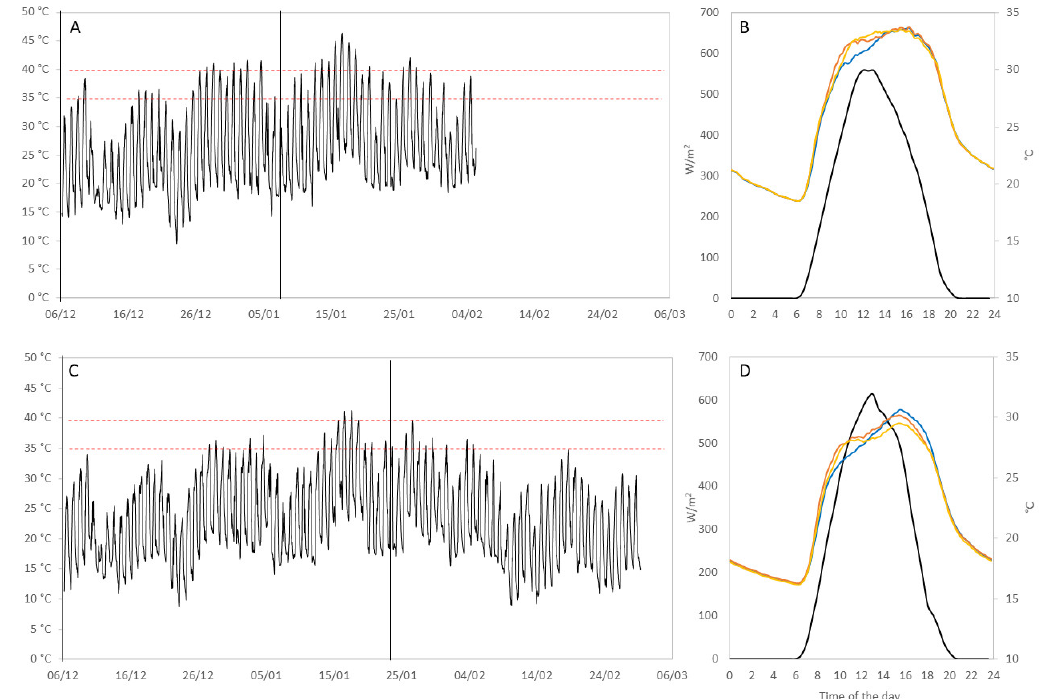
Figure 4. Growing season canopy temperature ( A , C ) and average daily solar energy and bunch temperature ( B , D ) at CUM (above) and BAL (below). ( A , C ) Red broken lines indicate temperatures above 35 and 40 °C, and black vertical lines indicate defoliation treatments (ED, 6/12 at CUM and BAL; LD, 08/01 at CUM and 23/01 at BAL). Canopy temperature was collected between flowering and harvest. ( B , D ) Canopy light interception is represented by black lines, and bunch temperatures by blue (ND), orange (ED), and yellow (LD) lines.